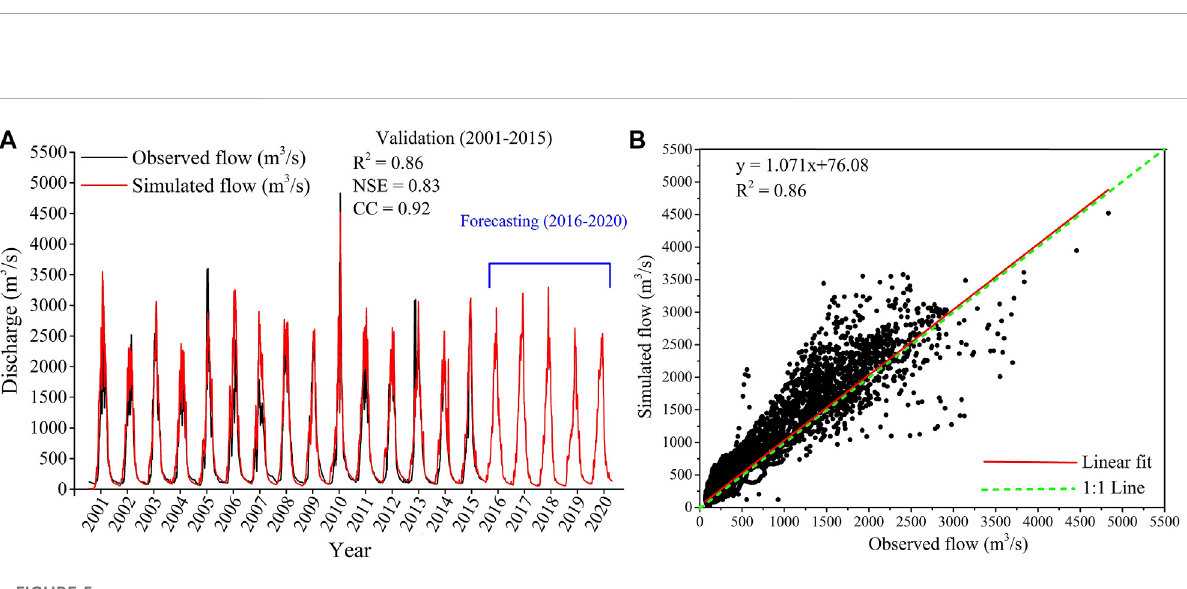
FIGURE 5 (A) Validation of UBC WM from 2001 to 2015 at Alam Bridge gauging station; (B) Scatter plot between observed and simulated stream fl ows during the validation